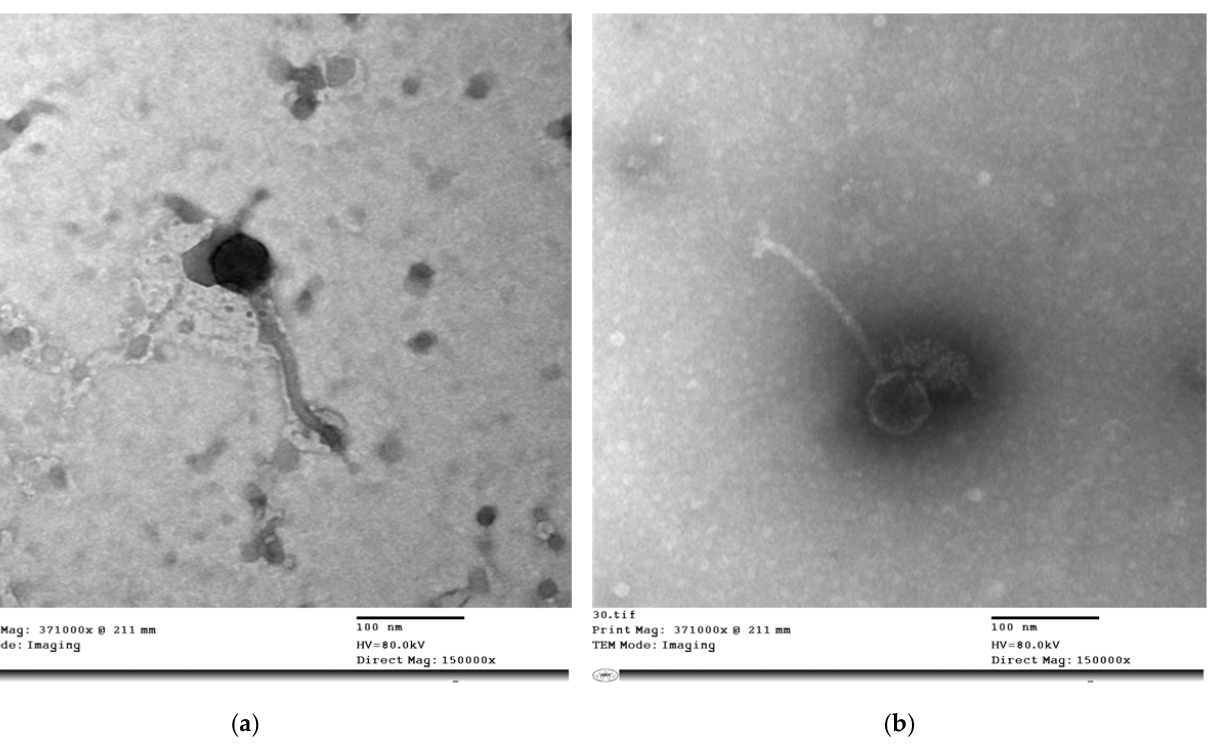
Figure 1. Electron micrograph of bacteriophages; ( a ) vB_Pae_SMP1, 60 ± 5 nm icosahedral head, flexible non-contractile tail 170 ± 5 nm long, ( b ) vB_Pae_SMP5, with an additional base plate containing 35 nm fiber at the end of the